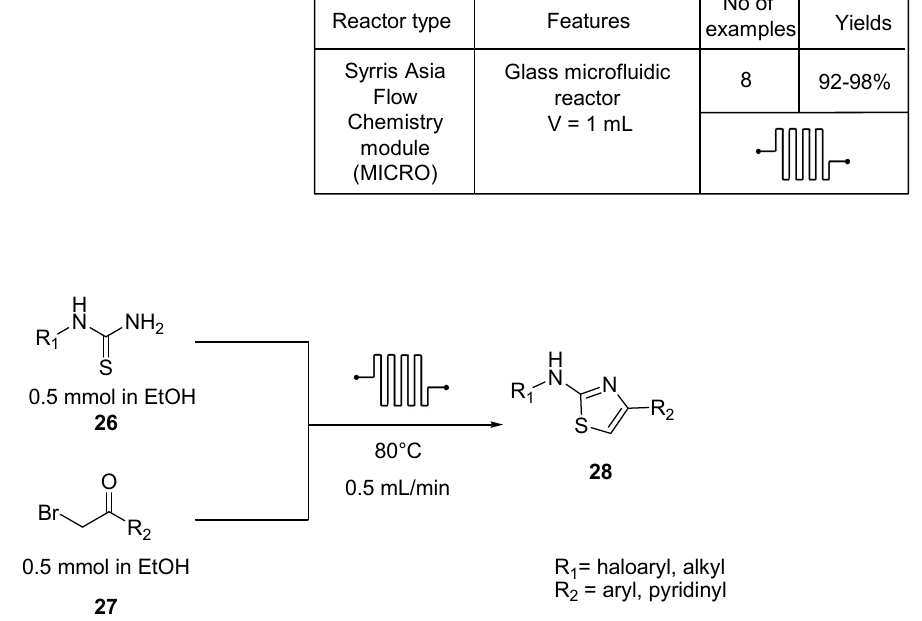
Scheme 8. Microfluidic flow protocol for the synthesis of small molecules mimetic of the Humanin